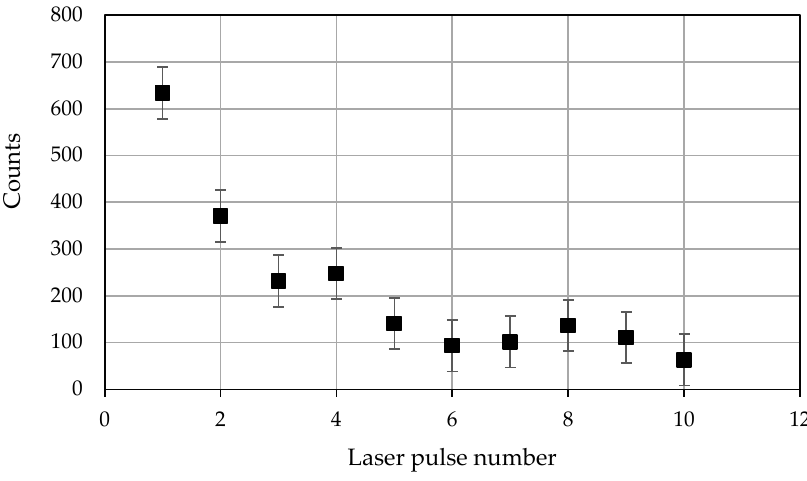
Figure 7. Peak intensity of the carbon line C I 247 nm for the 316L steel sample.